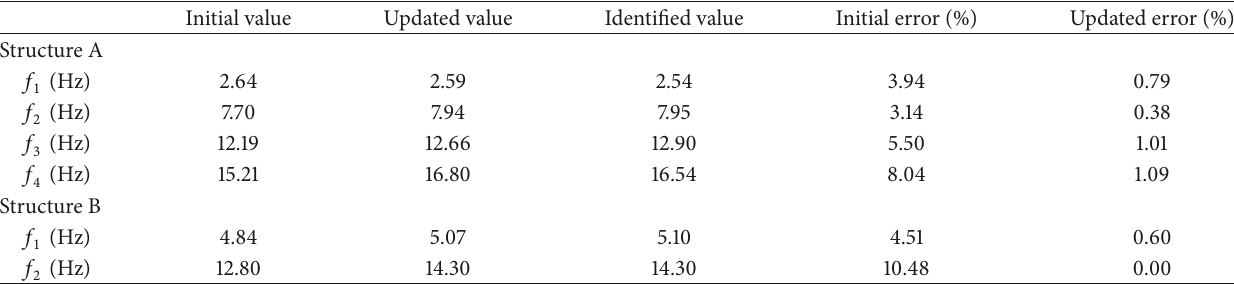
Table 5: Initial and updated FE model frequencies.